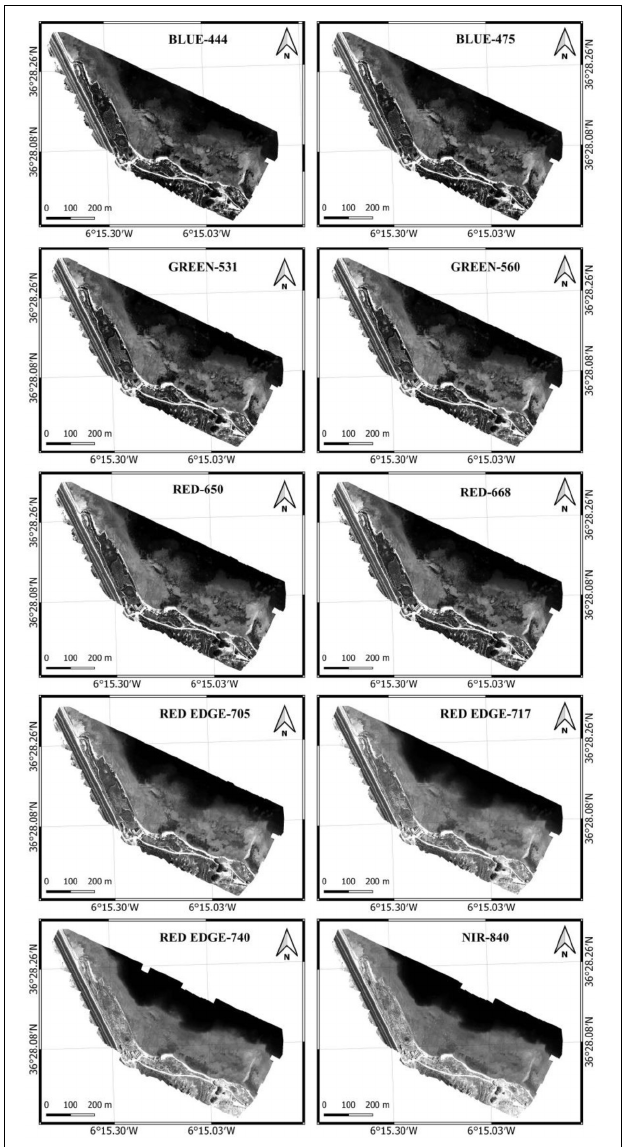
FIGURE 3 | At-sensor reflectance orthomosaics of multispectral bands in the study area.